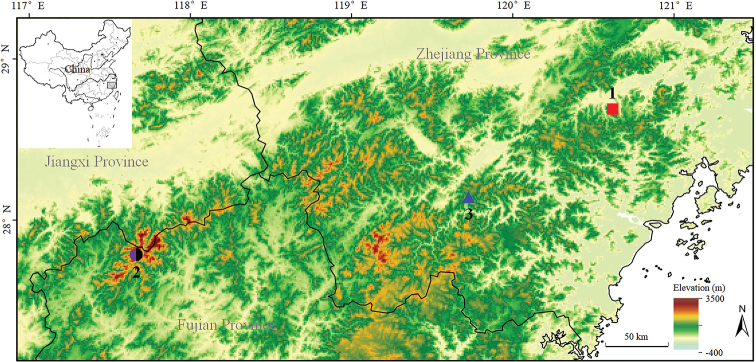
Localities for specimens used in this study. 1, the type locality of Megophrys
xianjuensis sp. nov., Xianju County, Zhejiang Province, China; 2. the common type locality of M.
boettgeri (black) and M.
kuatunensis (purple), Wuyi Mountain, Nanping County, Fujian Province, China; 3, the type locality of M.
lishuiensis, Lishui City, Zhejiang Province, China.